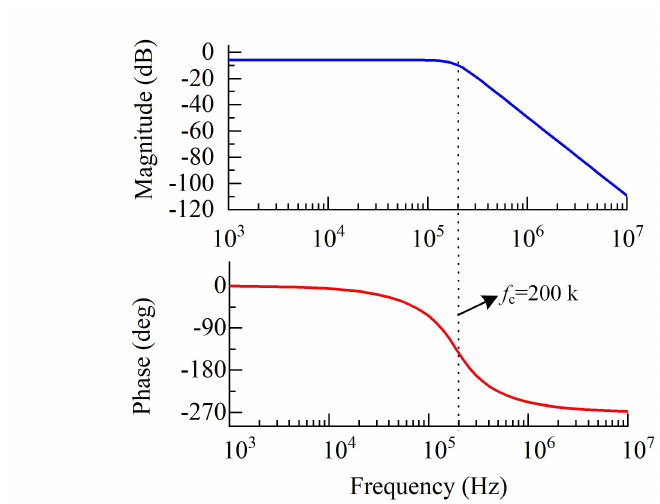
Figure 11. Bode plot of the designed